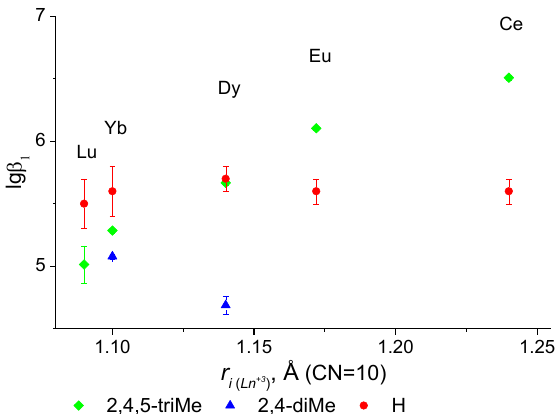
Figure 3. Dependence of the stability of (log β 1 ) lanthanide complexes on the ionic radius for the 2,3,4-triMe ligand when compared with unsubstituted diamide (H) [10] and 2,4-diMe diamide [12].